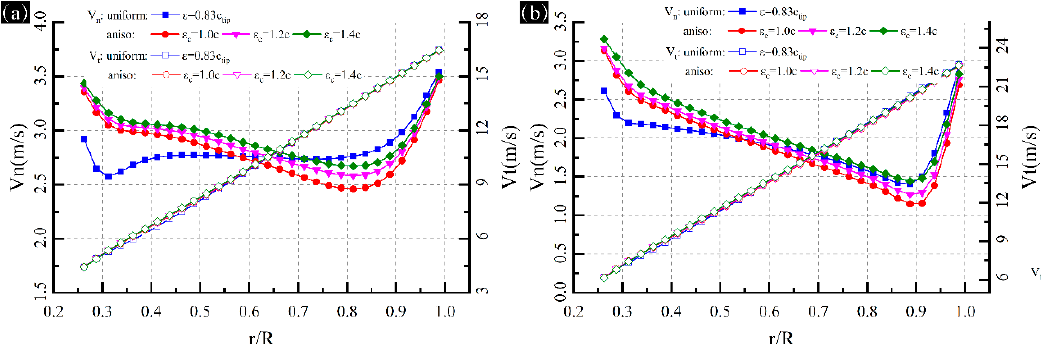
Figure 13. The V n and V t of each blade element along the blade when rotating speed is ( a ) 400 RPM, Figure 13. The V (cid:2924) and V (cid:2930) of each blade element along the blade when rotating speed is ( a ) 400 RPM, ( b ) 550 ( b ) 550 RPM.